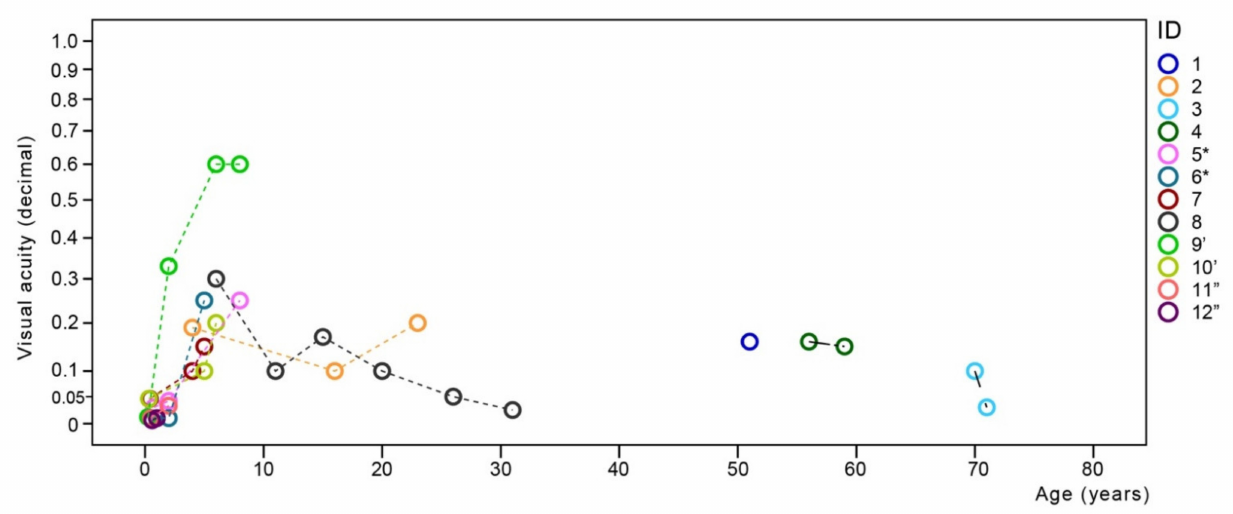
Figure 1. Visual acuity in relation to age. Chart showing best-corrected visual acuity in relation to age. Follow-up data are shown with interpolation lines. Note the increase of visual acuity in the first decade and relatively stable visual acuity afterwards with most patients retaining visual acuity of at least 0.05 decimal. Patients from the same families are marked with *, ’ and ”,